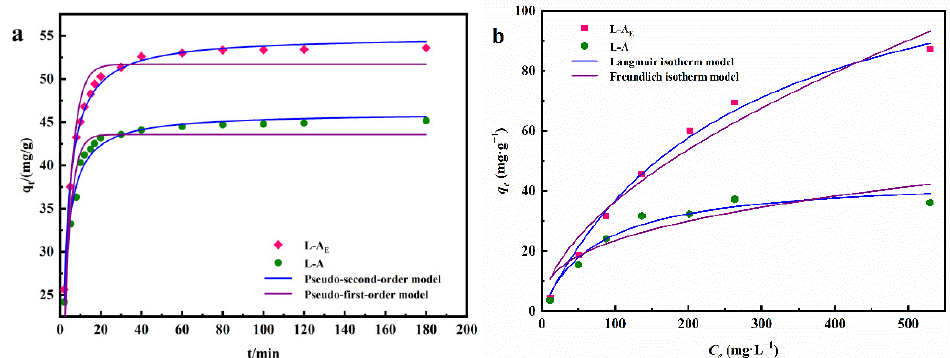
Figure 7. Adsorption kinetic curves ( a ) and isotherms ( b ) of phosphate on L-A E and L-A.